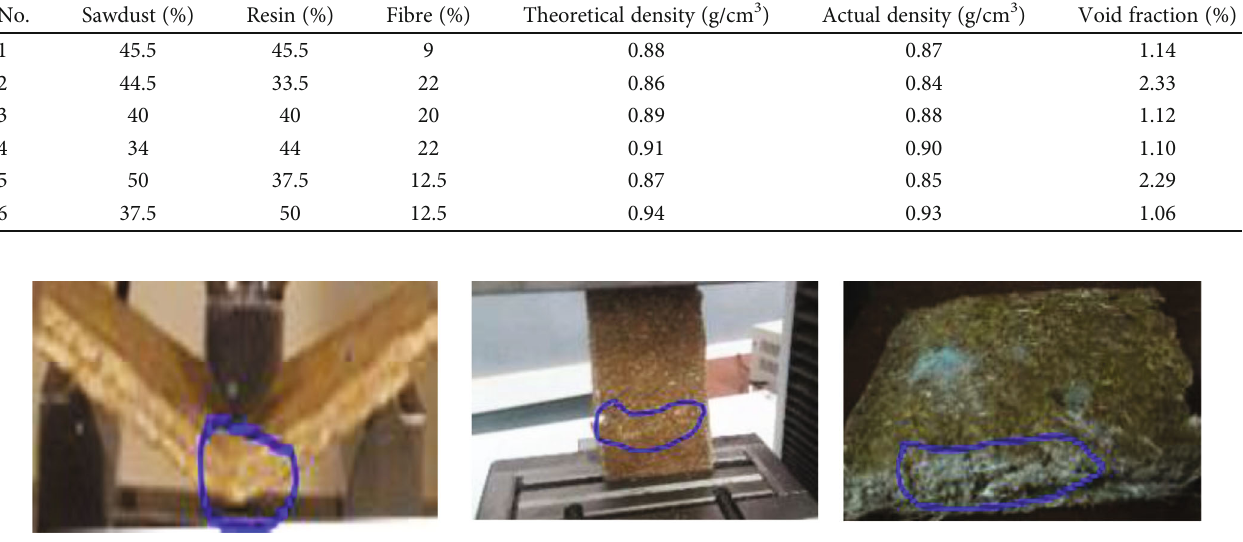
Figure 8: Damage